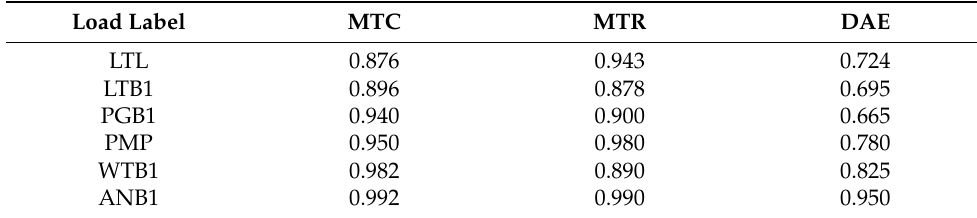
Table 11. F-score performance by the MTC and MTR approaches, and DAE network.